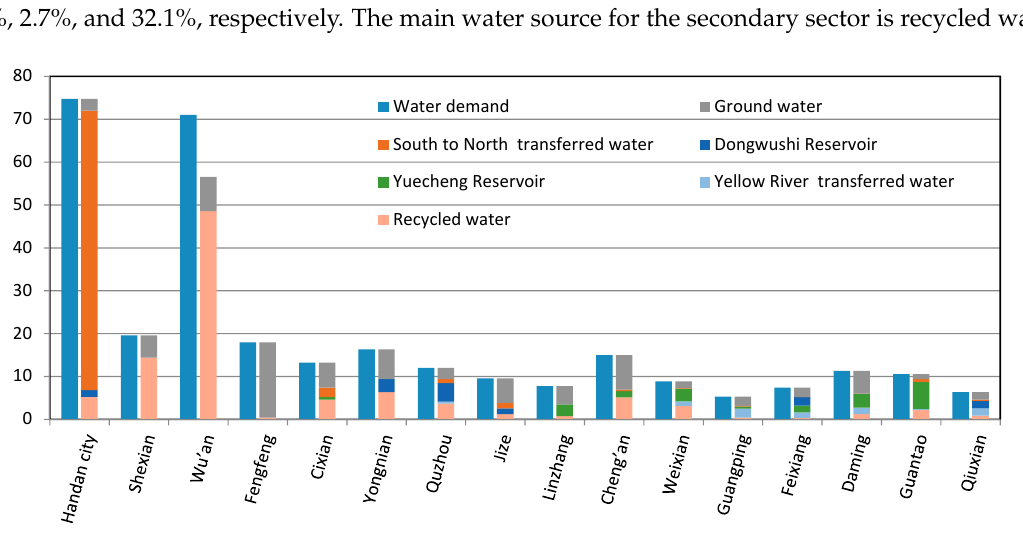
Figure 7. Secondary sector water allocation in each sub-region in Handan (10 6 m 3 ).